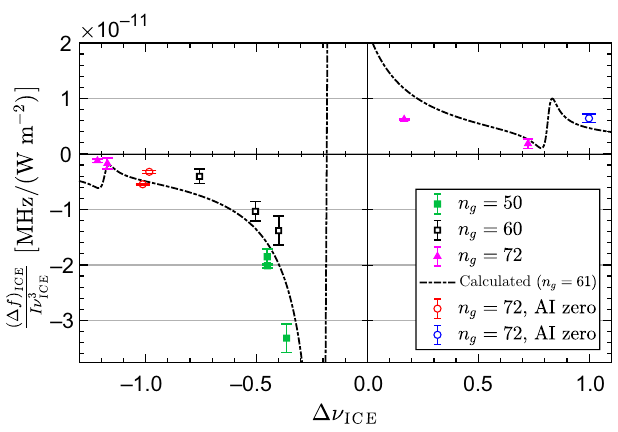
FIG. 7. The ICE light shift per unit intensity, rescaled by , extracted from Rydberg-excitation spectroscopy at n g = 1 /ν 3 ICE 50, 60, and 72. The dashed-dotted line presents the theoretical shift for n g = 61 using Eq.